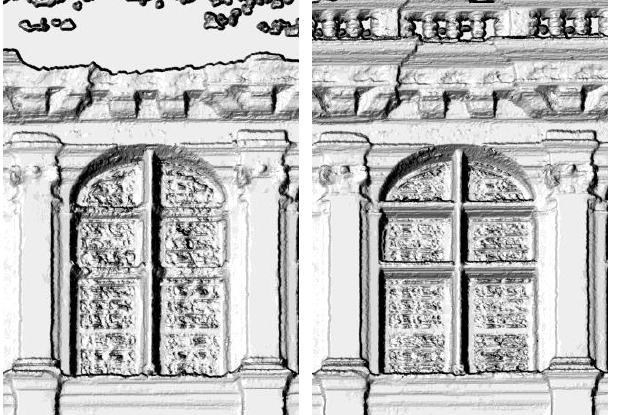
Figure 14: 3D reconstruction with 100 mm only and with 100 mm and 200 mm focal length images, on FNO2 upper part.